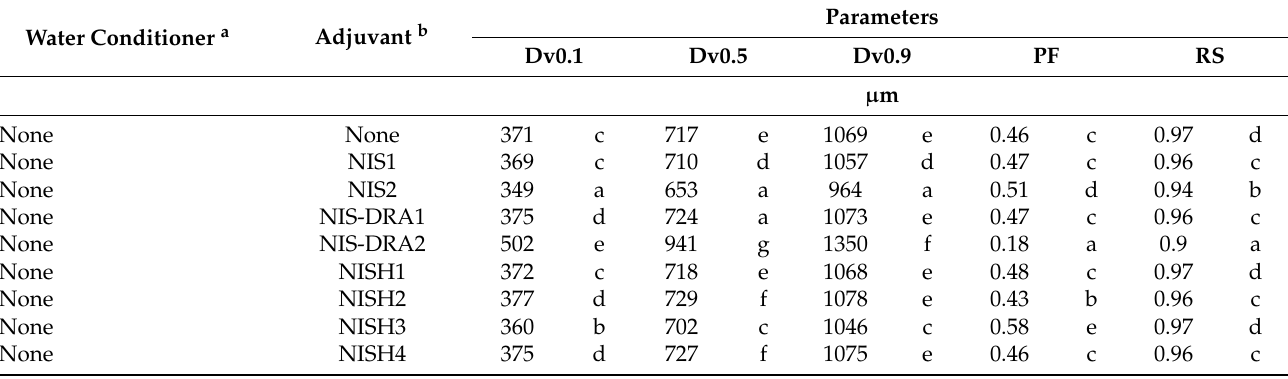
Table 8. Dv0.1, Dv0.5, and Dv0.9 (droplet diameters for which 10, 50, and 90% of the total spray volume is contained in droplets of lesser diameter, respectively), percentage of fines (PF) and relative span (RS) for dicamba plus glyphosate solutions at 559 and 1541 g ae ha − 1, respectively, with and without non-AMS water conditioner alone and tank mixed with 10 adjuvants at 246 kPa using TTI110015 nozzle. Water Conditioner